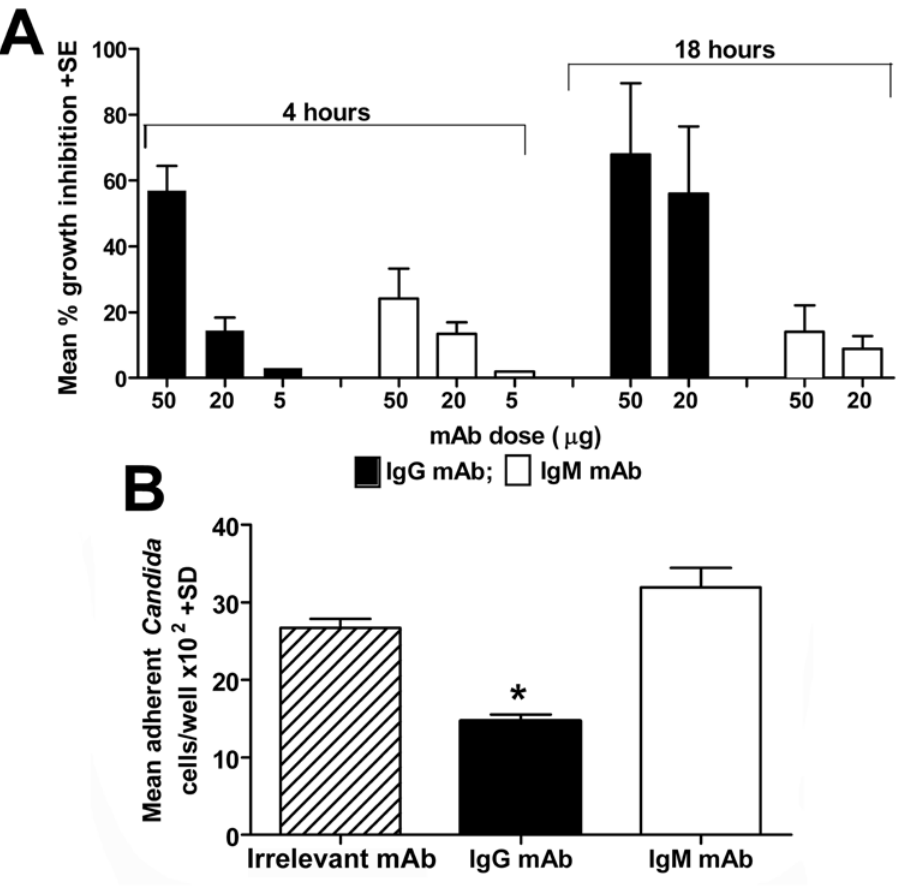
Figure 6. Antifungal properties of the anti- b -glucan mAbs. Panel A: C. albicans growth-inhibitory activity by the mAbs. C. albicans cells were cultured at 37 u C in the presence or in the absence of the indicated mAb doses and, after 4 or 18 hours of incubation, fungal growth was estimated by a standard CFU counts. Percent growth inhibition values are from three independent experiments and were calculated by comparison to fungal cultures with equal doses of heat-inactivated mAbs or with an irrelevant mAb. Statistically significant differences between growth inhibitory activities by the IgG and the IgM mAb are marked by asterisks. Panel B: ability by the mAbs to inhibit adherence of Candida to human epithelial cells. Monolayers of Hep-2 cells were put into contact with fungal cells which have been pre-treated with the IgG, the IgM or with an irrelevant mAb as indicated. After a 1 h contact at 37 u C, co-cultures were gently washed to eliminate non adherent fungi. Adherent fungal cells were recovered from the wells and enumerated by a standard CFU counts. Data in the graph are from three independent experiments, each performed in